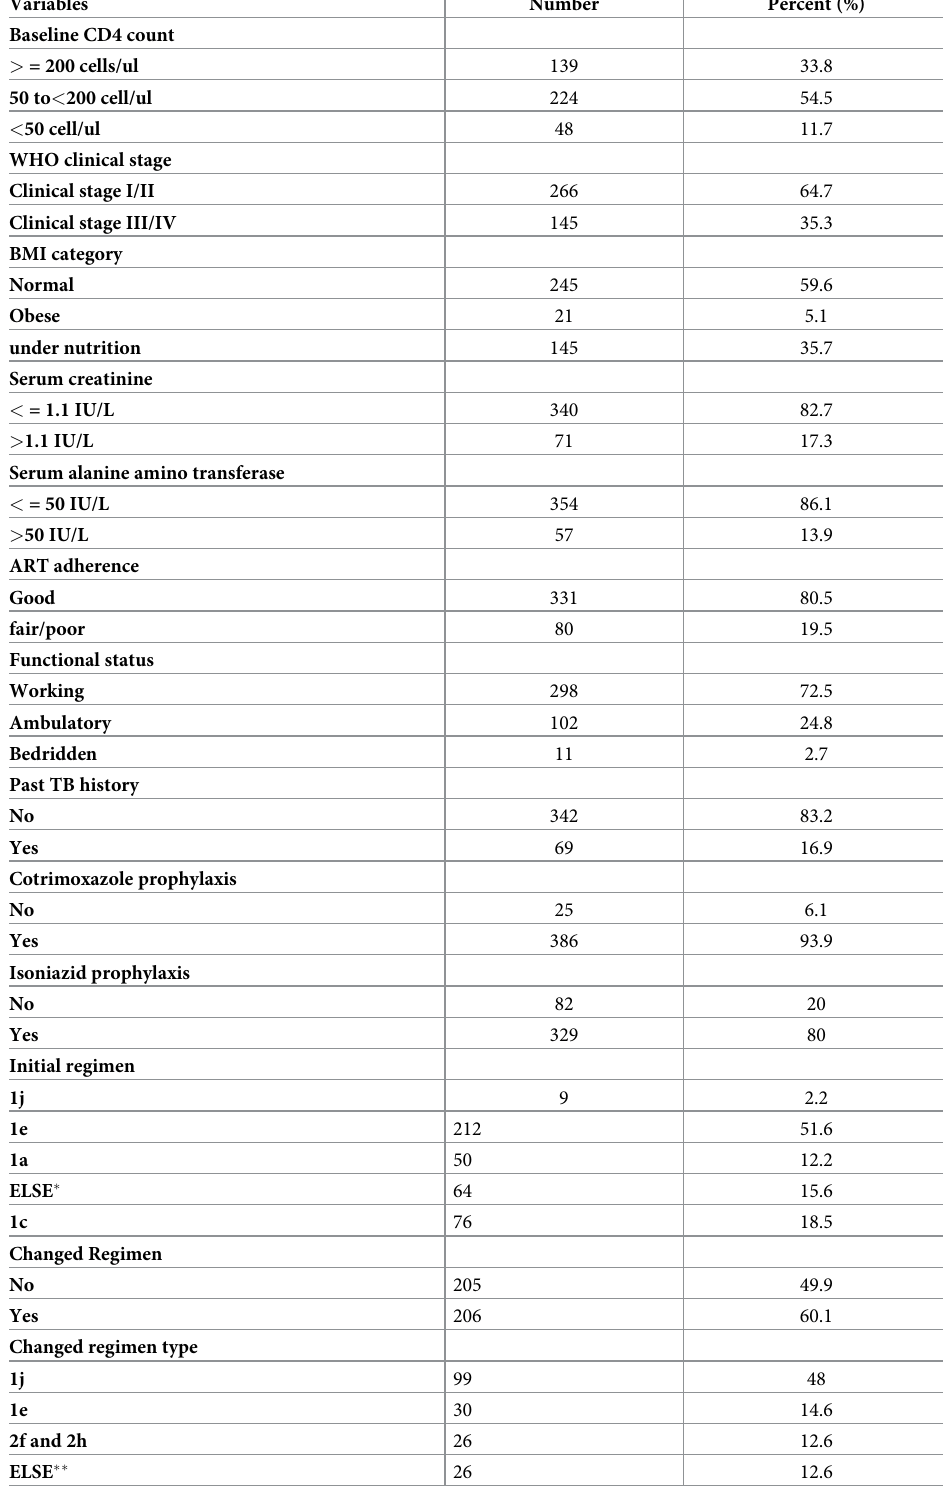
Table 2. Baseline clinical and treatment related characteristics of adults on HIV